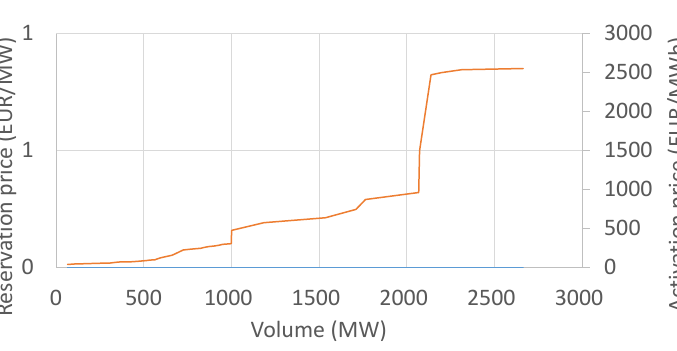
↑ ) and activation ( λ a ↑ t